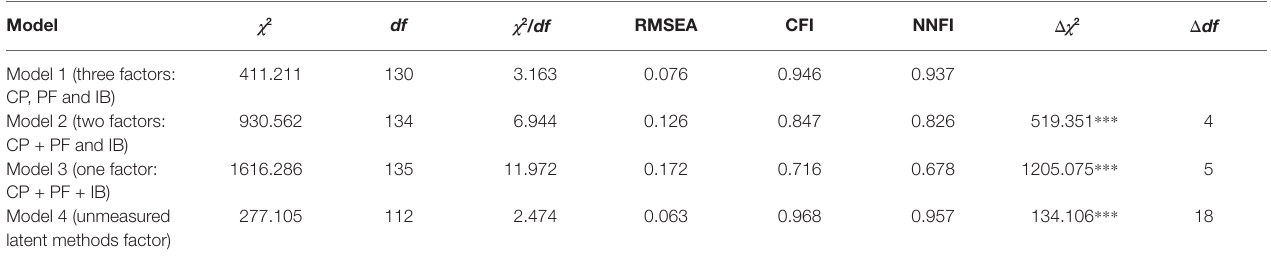
TABLE 1 | Results of confirmatory factor analysis ( n = 374).